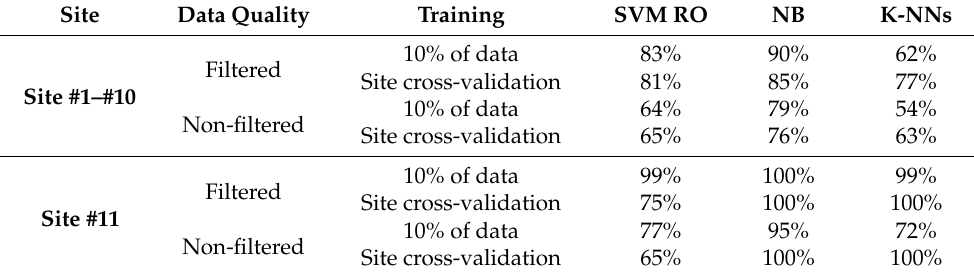
Table 5. Product of accuracy and posterior probability for each training approach.